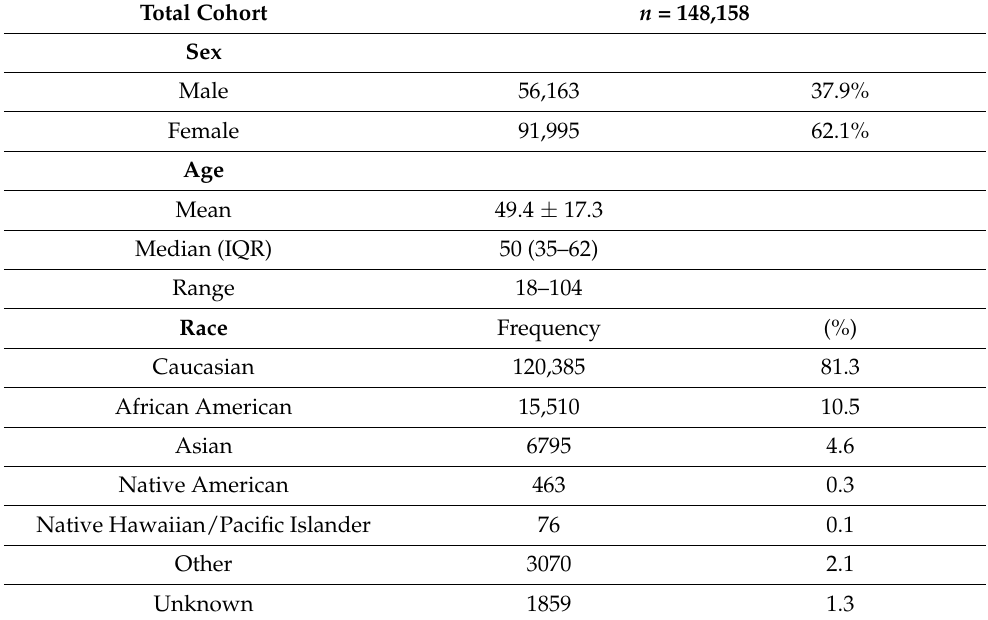
Table 1. Baseline Population Demographics for the entire cohort.